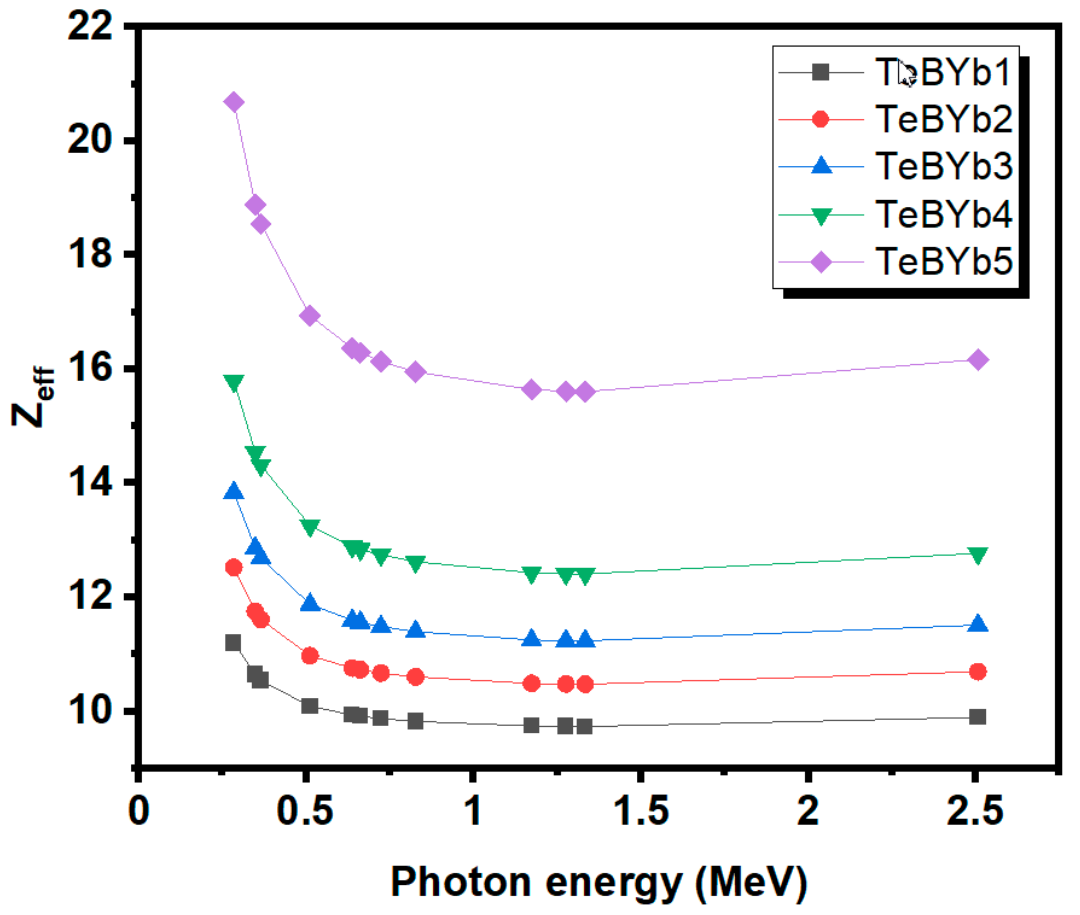
Table 1. Samples’ codes, composition (mol%) for the TeBYb-X glasses.